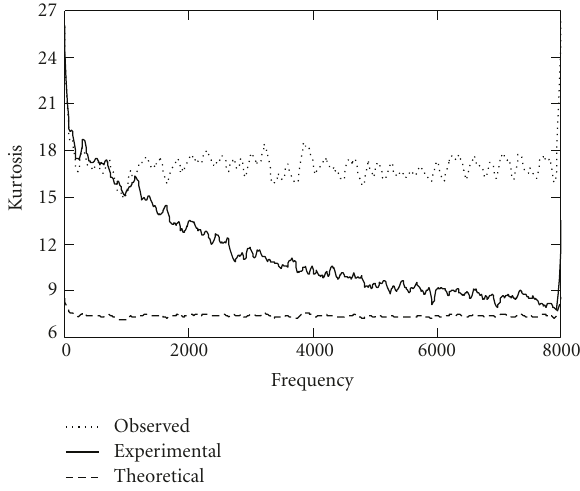
Figure 9: Simulation result for noise with interchannel correlation (solid line), theoretical e ff ect of DS assuming no interchannel correlation (broken line), and kurtosis of the observed signal without any signal processing (dotted line) in eight-microphone